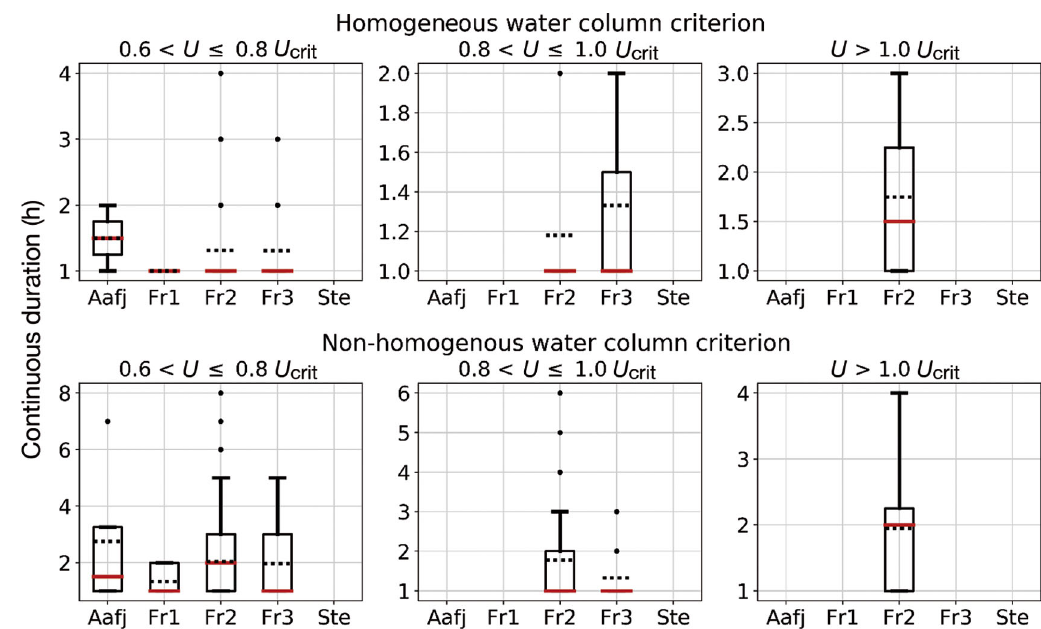
Fig. 8. Number of consecutive hours where the currents were within given ranges of the critical swimming speed ( U crit ) for Atlantic salmon Salmo salar using both the homogeneous and non-homogeneous criterion. Other details are the same as for